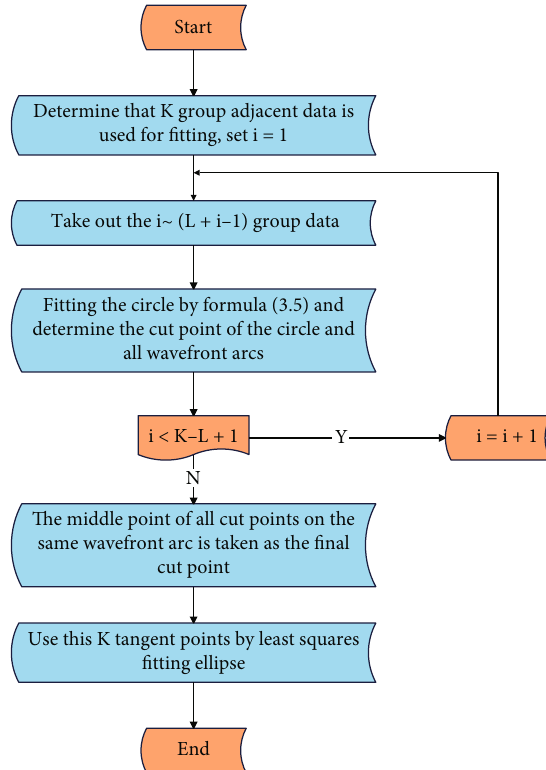
Figure 4: Flow chart of reconstruction of tangent elliptical defect